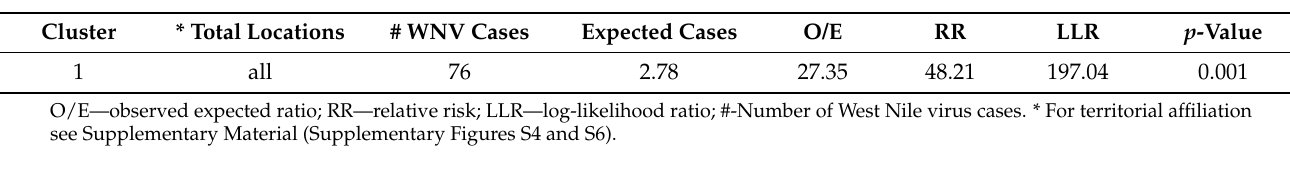
Table 2. SatScan TM purely temporal cluster analysis. The clusters of WNV cases detected by using purely temporal cluster statistics.